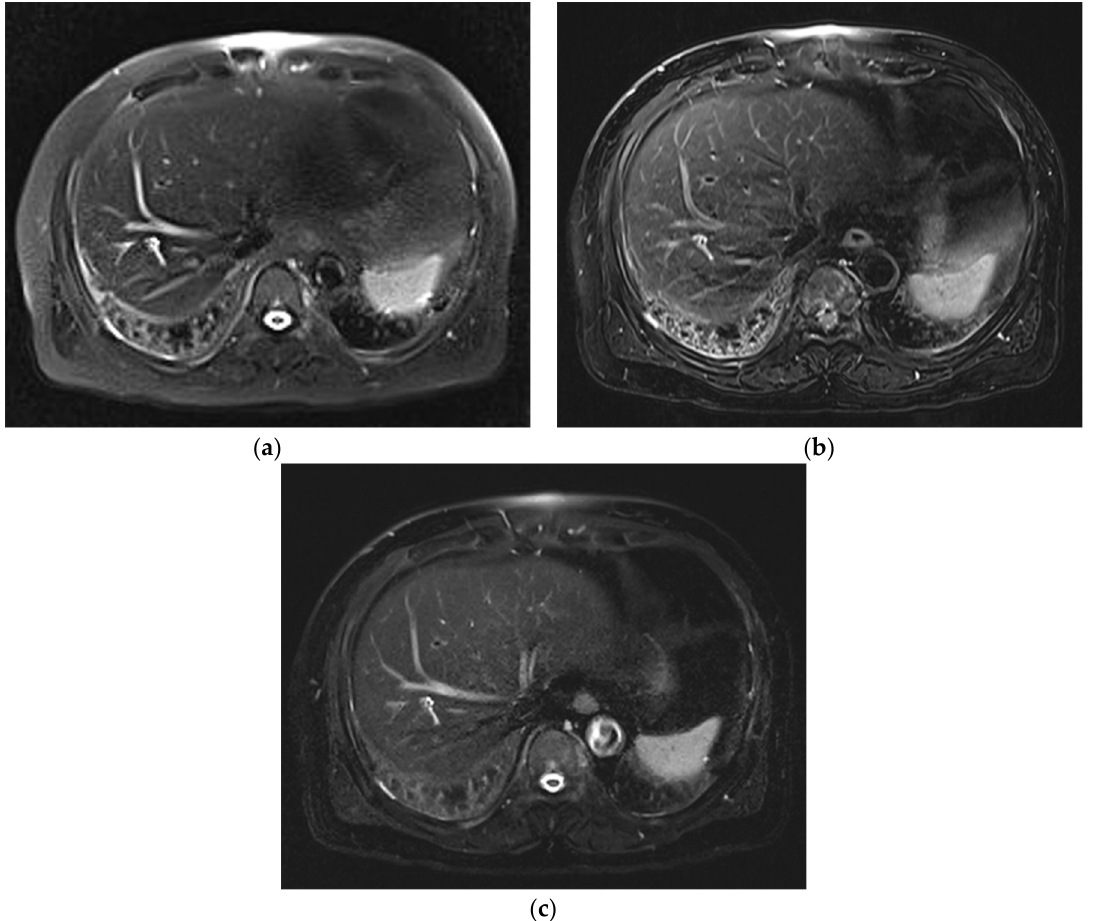
Figure 1. Comparison of image artifacts in three T2WIs acquired on Skyra. SSFSE CONV ( a ) was rated 3, mTSE ( b ) was rated 2, and SSFSE CS ( c ) was rated 4. On SSFSE CONV and mTSE, cardiac motion artifacts, as well as some respiratory motion artifacts, are present.